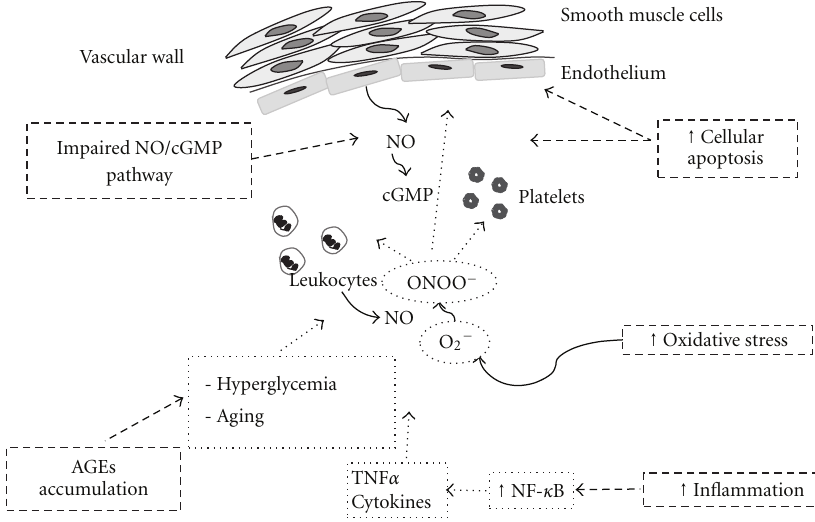
Figure 1: Known mechanisms involved in hypertension in the elderly population. Impairment of the NO/cGMP system, increased cellular apoptosis, and increased concentration of active metabolites such as advanced glycation end products (AGEs) together with an enhanced oxidative an inflammatory state are well-known mechanisms that contributes to the development of hypertension in the elderly